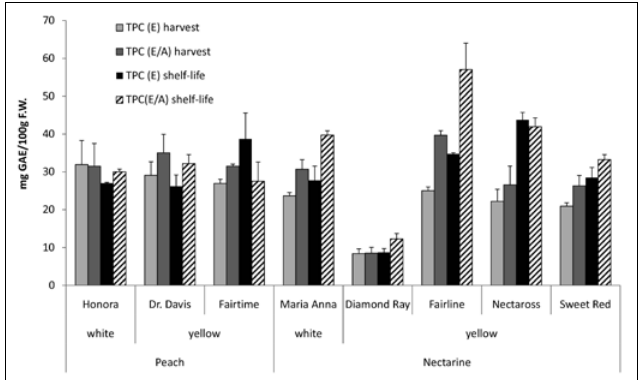
Fig. 2 - Total phenol content (TPC) of ethanol/HCl (E) or ethanol/ac- etone (E/A) extracts from flesh of different peach and nectarine cultivars at harvest and after five days of shelf-life at 20°C. Bars refer to standard error.